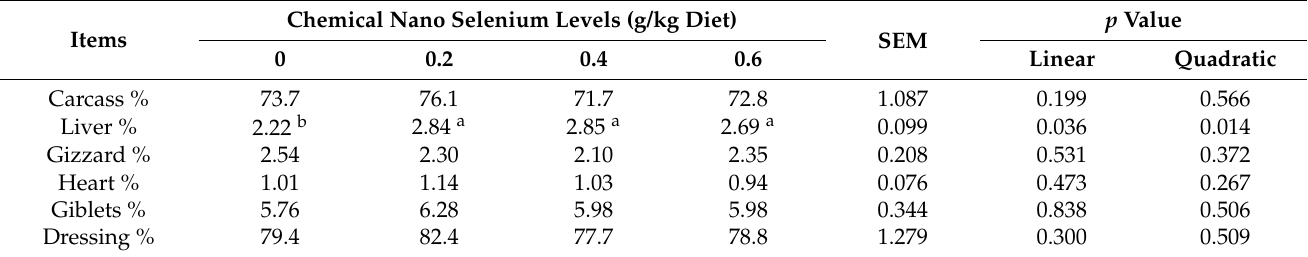
Table 5. Carcass traits and relative organs of growing Japanese quail as affected by dietary treatments.